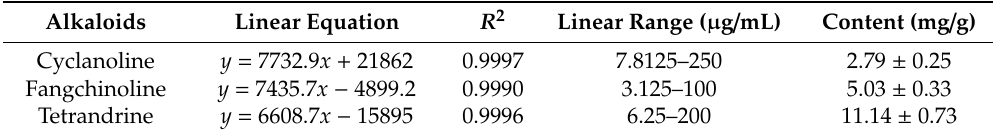
Table 1. The linearity curves and contents of main alkaloids in STR crude drug.